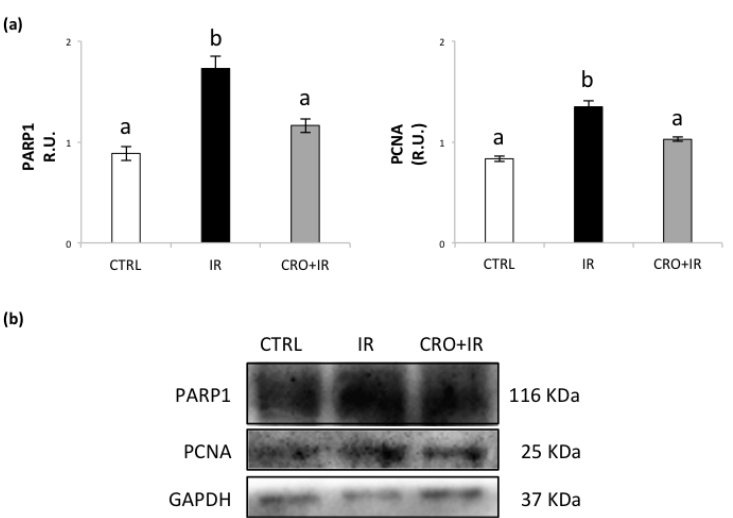
Figure 2. ( a ) Western blot analysis of PARP1 and PCNA protein levels. ( b ) Representative images of immunoreactive bands. Data are presented as means ± SEM of densitometric analysis of immunoreactive bands normalized to internal reference protein (GAPDH). One-way ANOVA p < 0.05; a,b p < 0.05, Holm–Sidak post hoc multiple comparison.